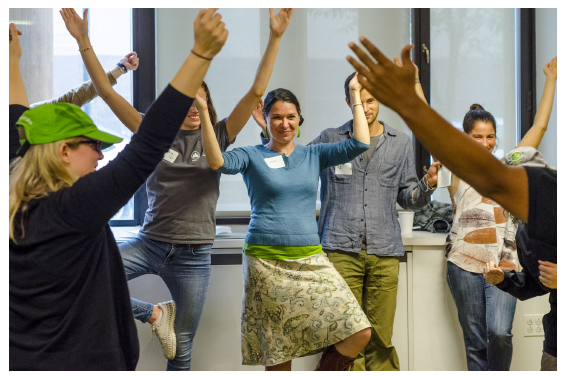
Fig. 4 . Learning from Place workshop participants perform their collaboratively created origin stories.